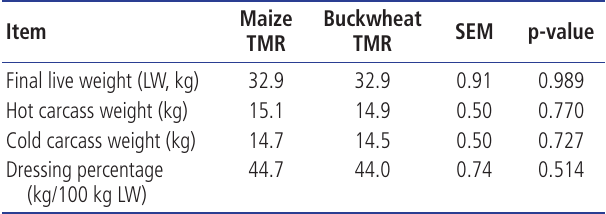
Table 4. Final live weight and carcass parameters of lambs fed maize or buckwheat TMR Item